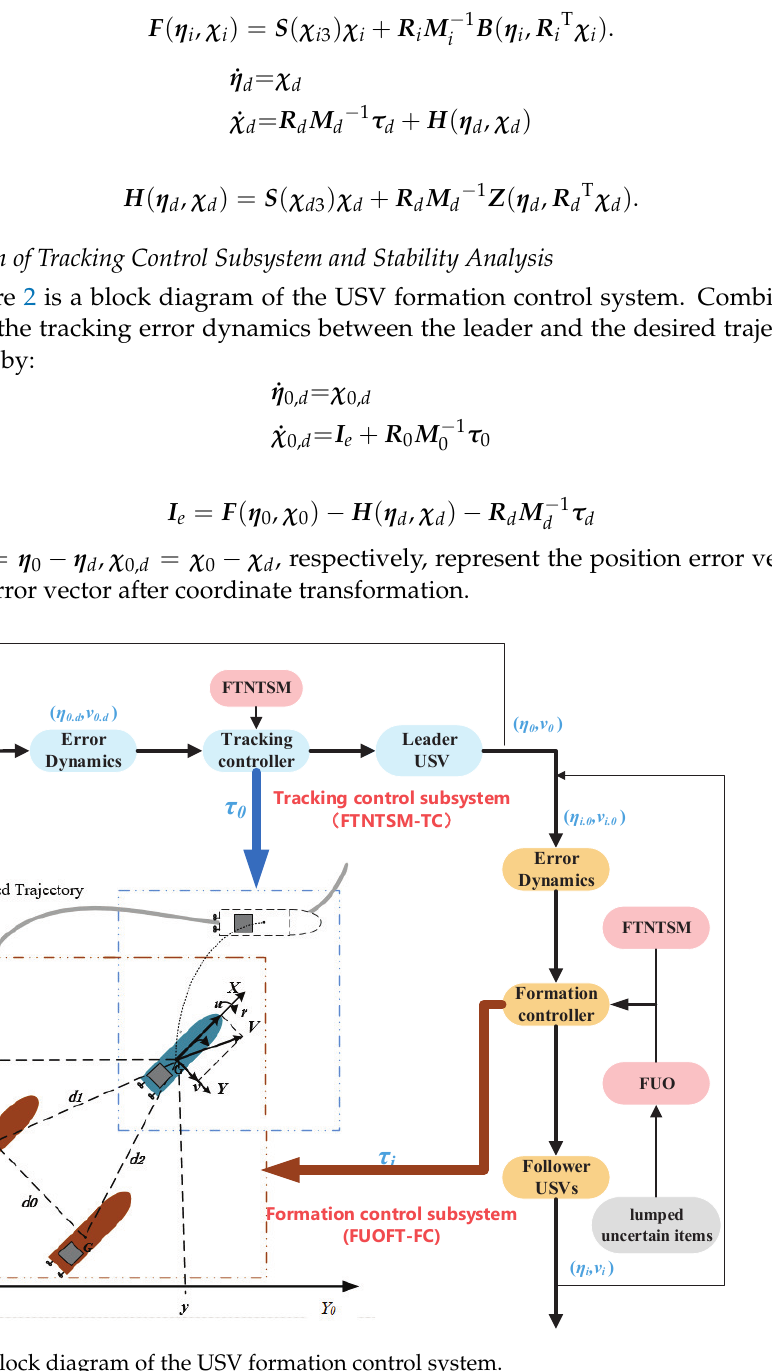
Figure 2. Block diagram of the USV formation control